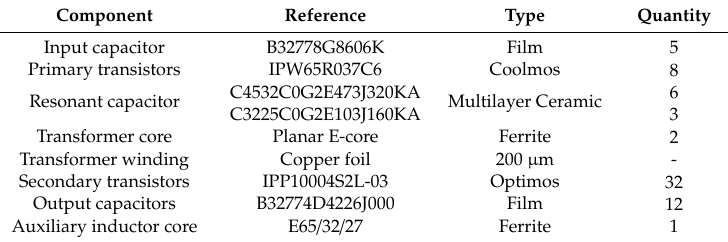
Table 6. Prototype components.